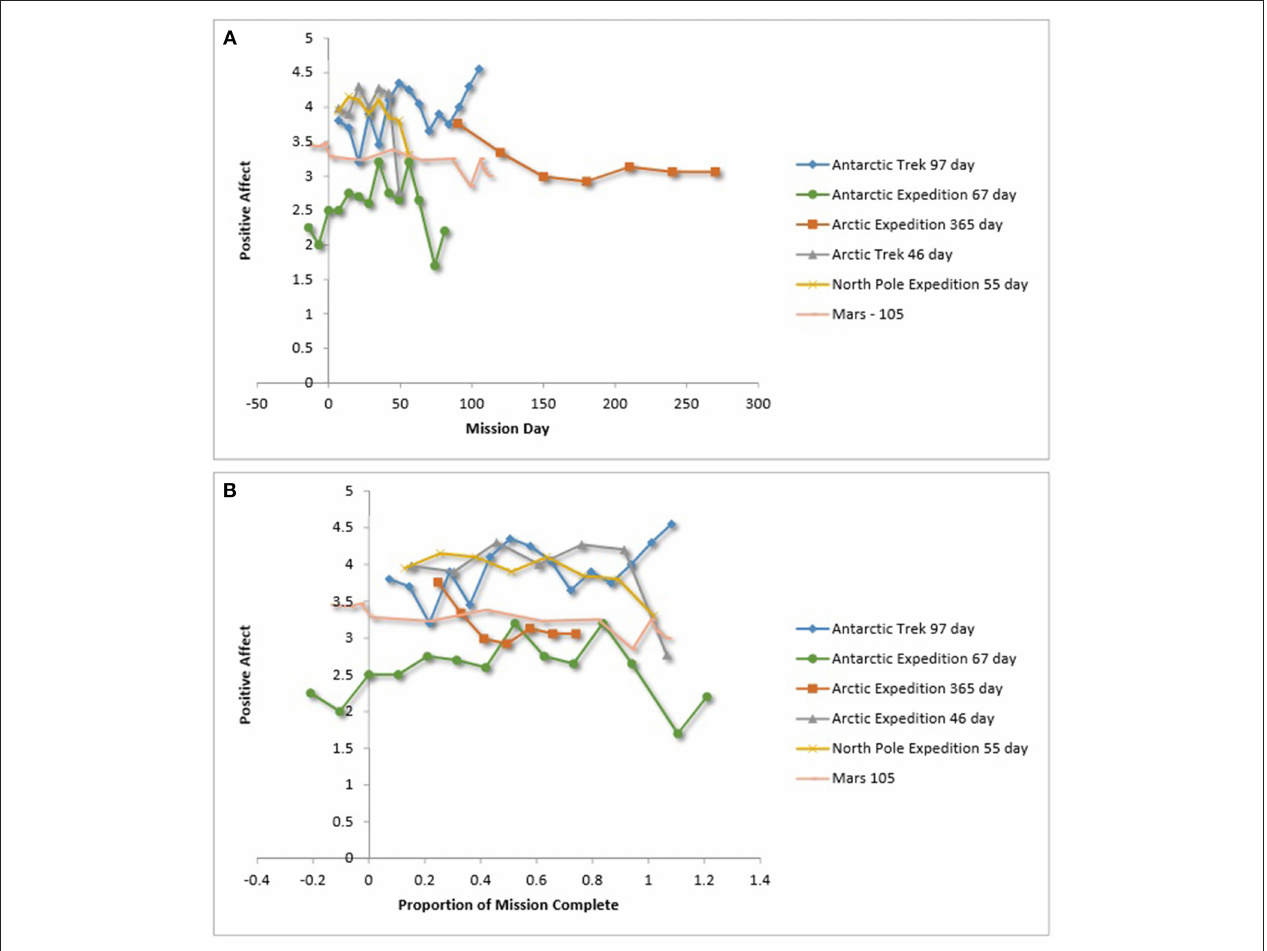
FIGURE 9 | (A) Team positive affect over time. (B) Team positive affect over relative time. Kahn and Leon (2000), Steel (2001), Atlis et al. (2004), Leon et al. (2004), Leon et al. (2011), Nicolas et al. (2013). Binsted (2015) provided unpublished data that may be later published. Because of the level of granularity of these figures, the data are not